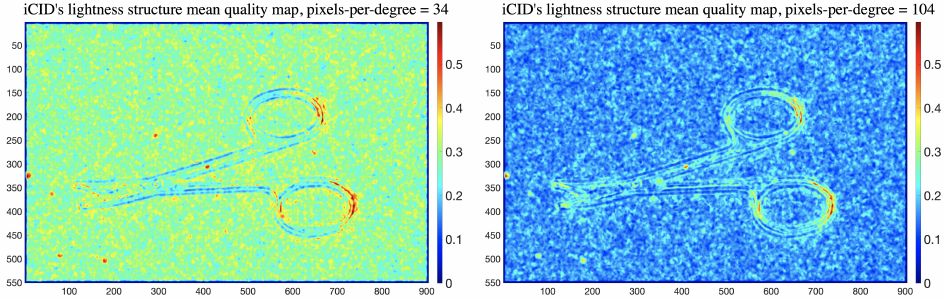
Figure 7. iCID’s lightness structure mean quality maps for the scissor image with 1 mm maximum height print used as test image and 0.25 mm maximum height print used as reference image from the MS captures with lower ( left ) and higher ( right ) pixels-per-degree values. We see that halftone noise was reduced with higher pixels-per-degree value, where the quality values are closer to zero (meaning higher